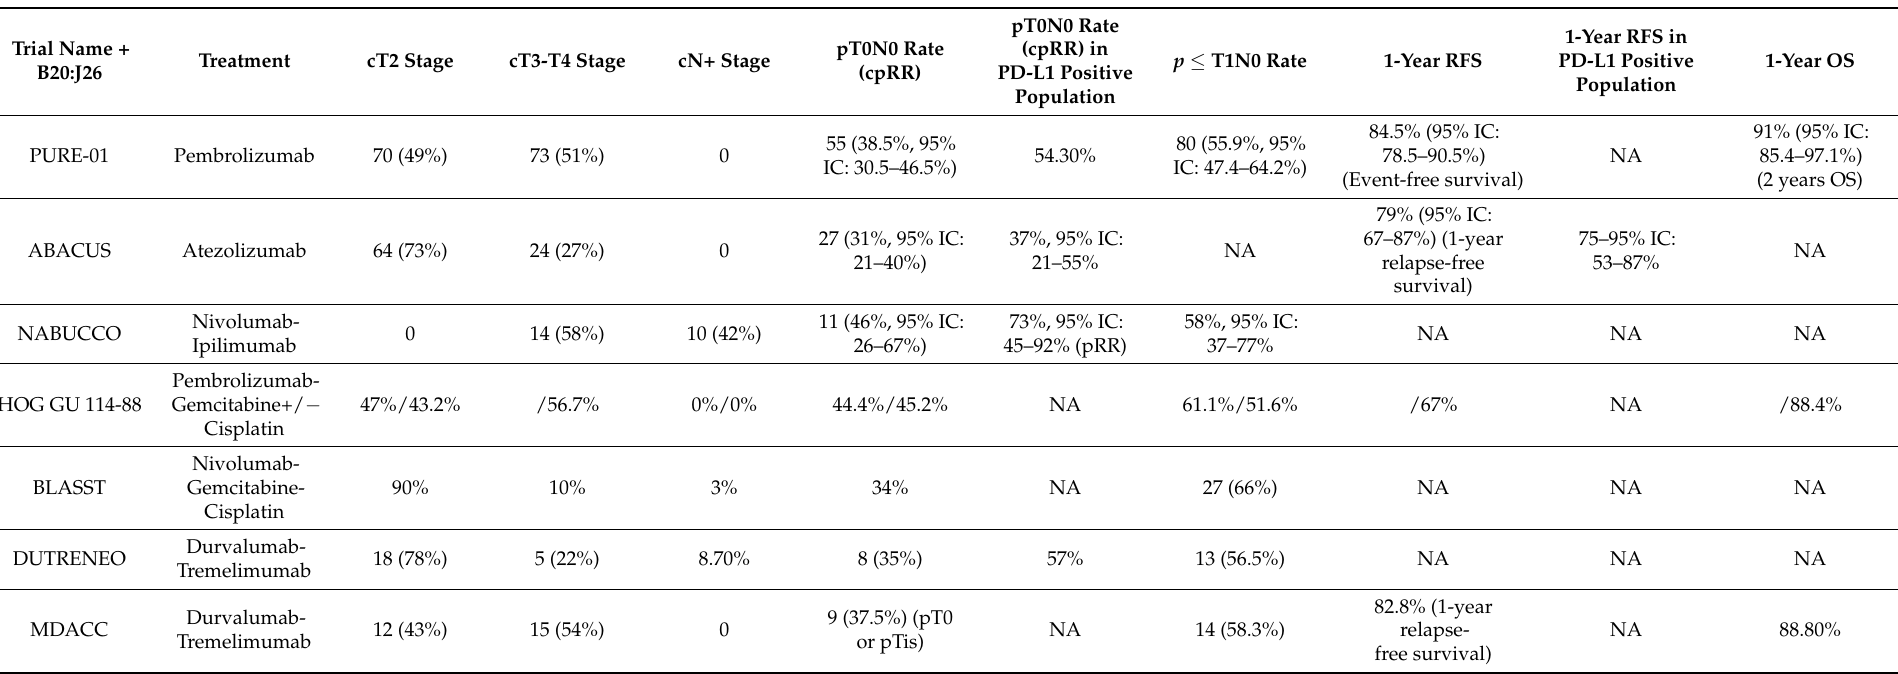
Table 2. Oncological outcomes of published or communicated studies on neoadjuvant ICIs in muscle-invasive non-metastatic bladder